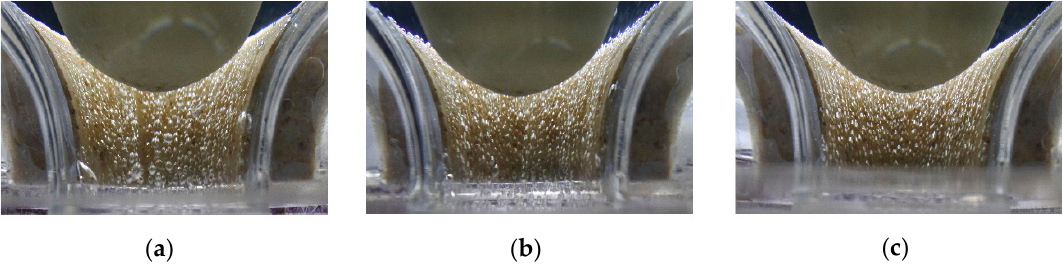
Figure 7. Distribution of argon bubbles on the inner surface of the nozzle for different casting speeds: ( a ) 0.4 m/min; ( b ) 0.5 m/min; ( c ) 0.6 m/min. ( a ) 0.4 m/min; ( b ) 0.5 m/min; ( c ) 0.6